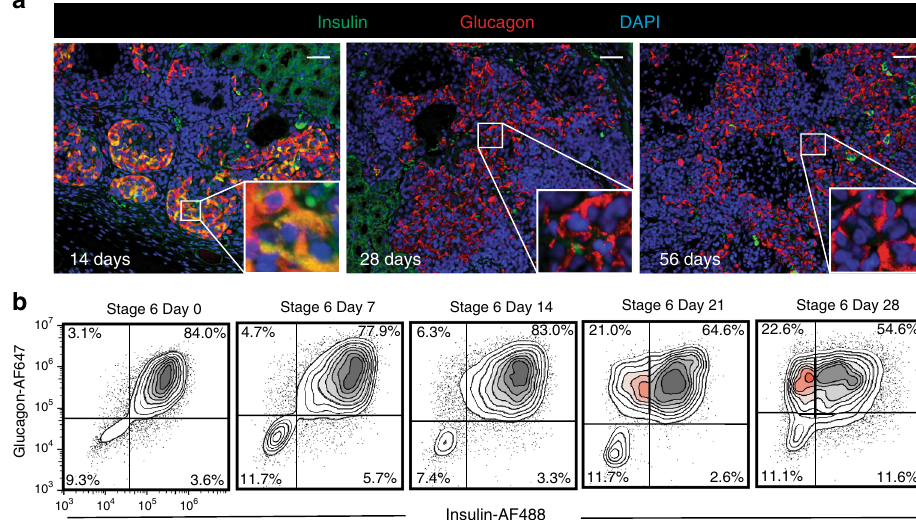
Fig. 2 Insulin expression is reduced following transplantation and extended culture in vitro. a Expression of insulin and glucagon in grafts after transplantation of pre-alpha cells under the kidney capsule of mice ( n = 10 animals) at 14 days (left), 28 days (middle) and 56 days (right) post transplant. Inlay shows zoomed-in view of cells at each time point. Coexpression of insulin and glucagon is observed at 14 days. At 28 and 56 days, insulin expression is absent from the majority of cells. Images are representative of n = 2 grafts harvested at each time point. Grafts harvested at 4 and 7 days are not shown. Scale bar = 50 μ m. b Extended culture in vitro results in a fraction of pre-alpha cells reducing insulin expression and continuing to express glucagon (highlighted in red). After 28 days extended culture, about 23% of cells express glucagon but not